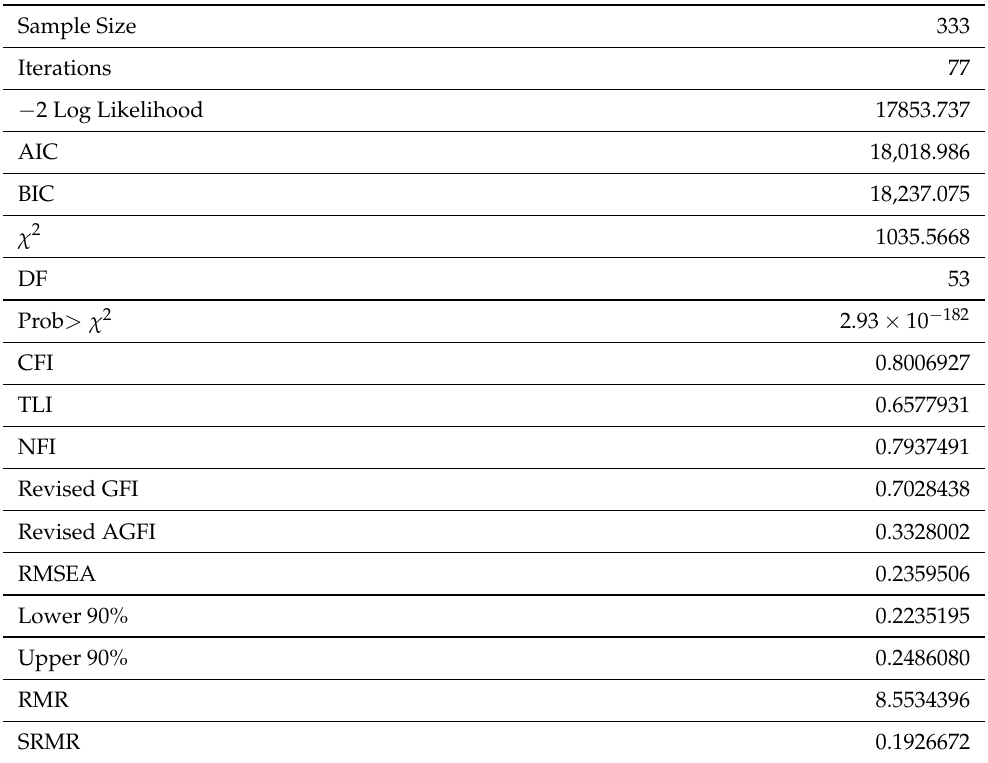
Table 4. Summary of fit for the Israeli data (JMP Pro version 16).